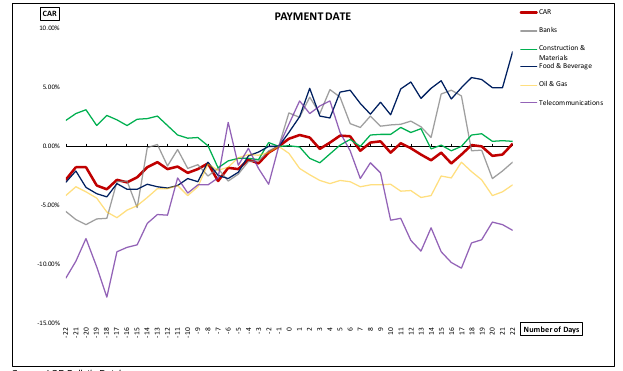
Figure 3: Cumulative abnormal returns around the announcement date of the payment of the fine by the convicted